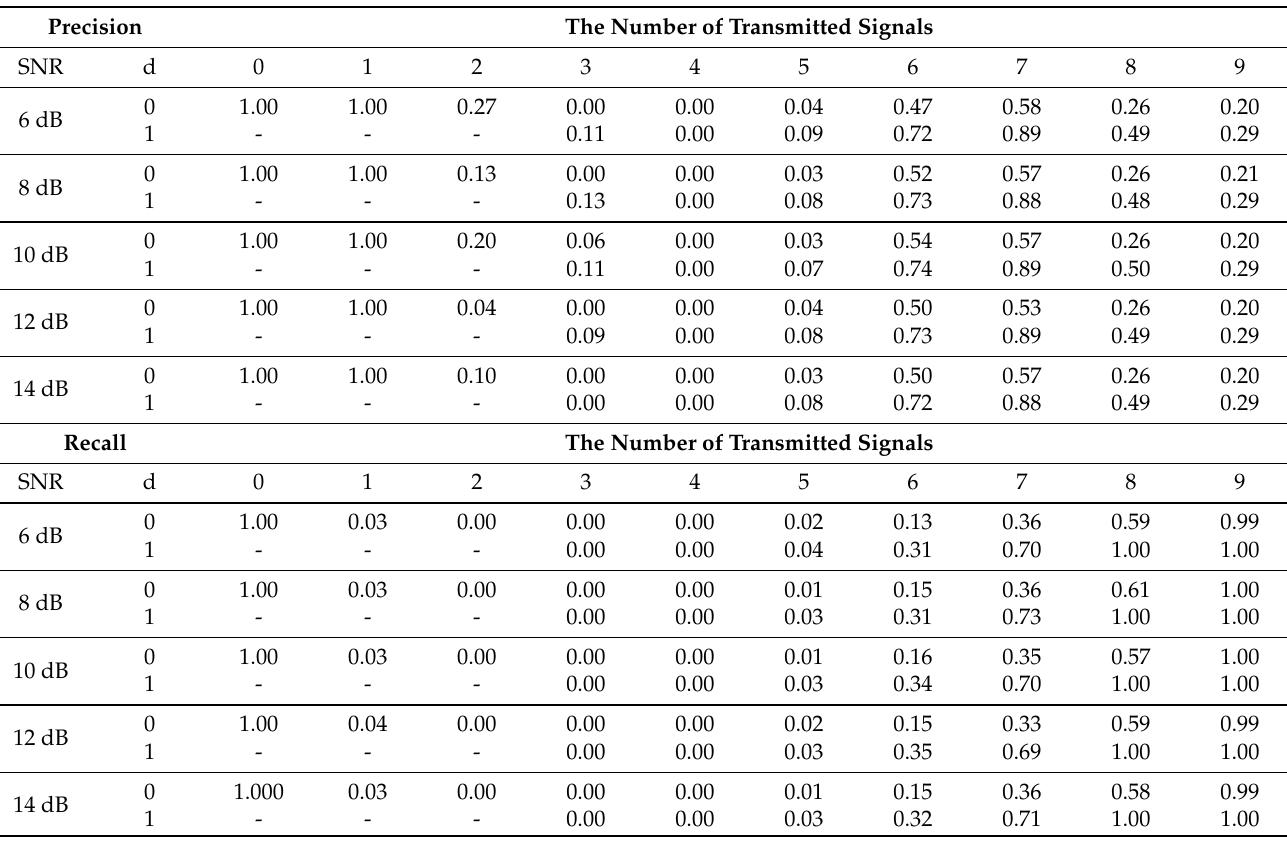
Table 4. Precision and recall of AIC.